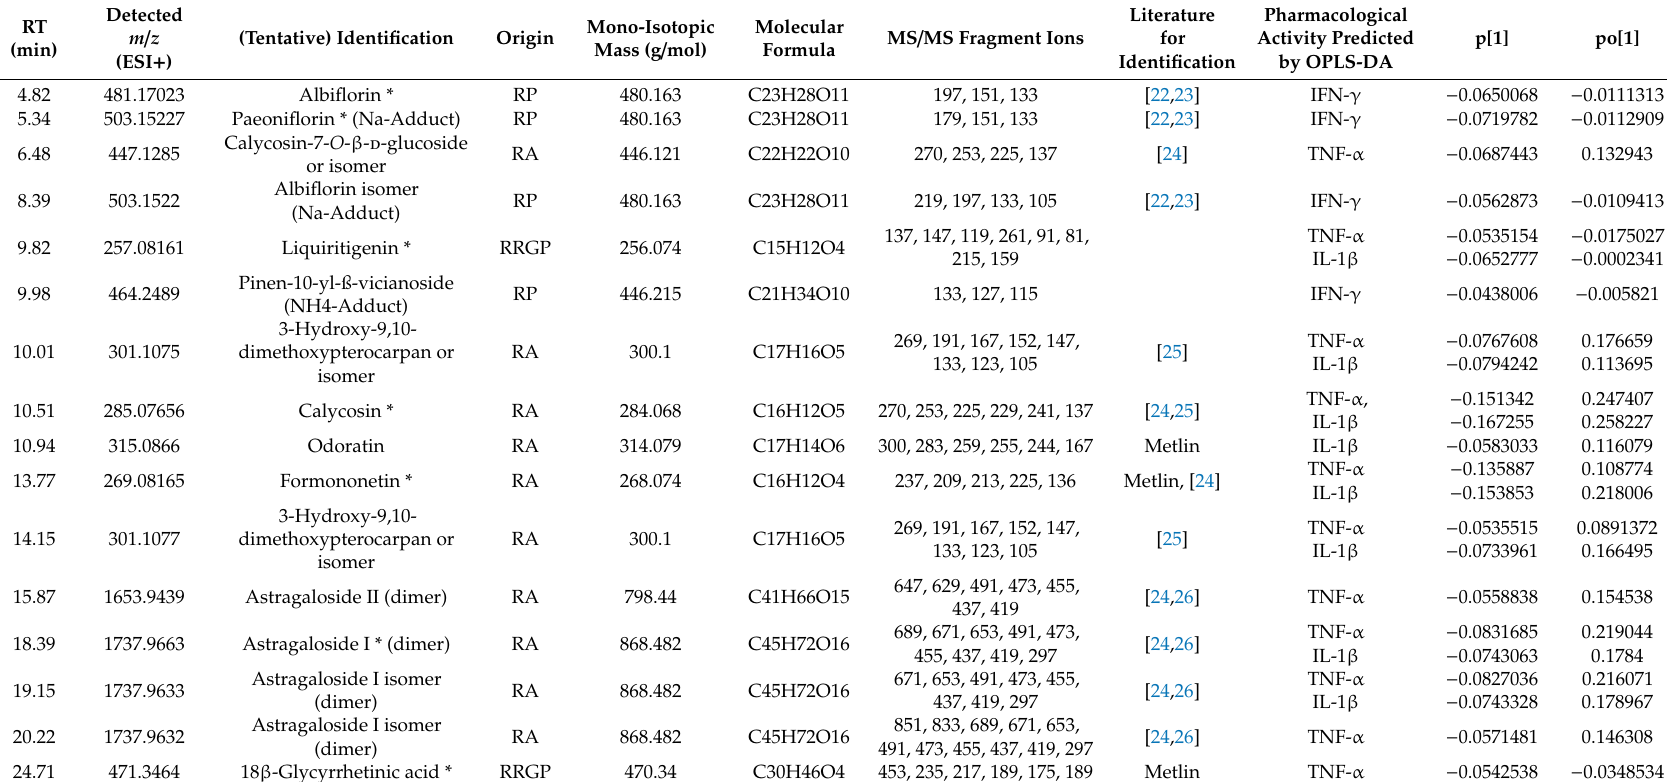
Table 2. Summary of all tentatively identified hit compounds from the three tested